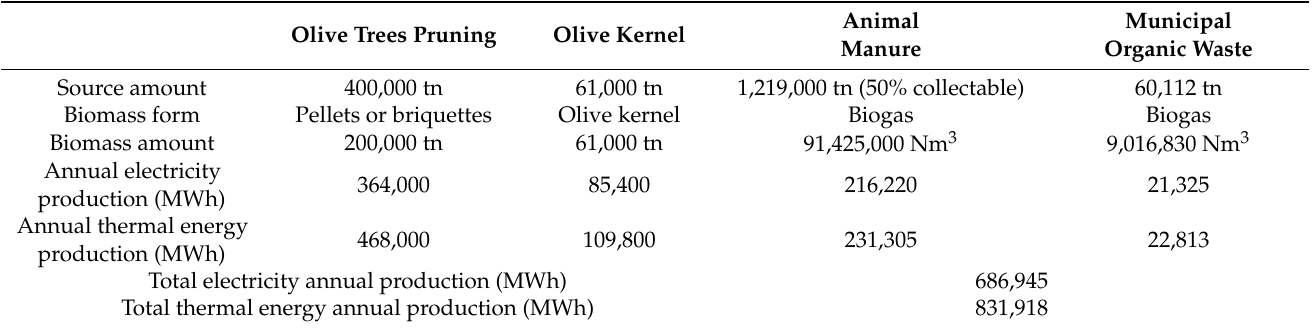
Table 5. Annual power and thermal energy production potential based on the available biomass and biomass residues in Crete Island,